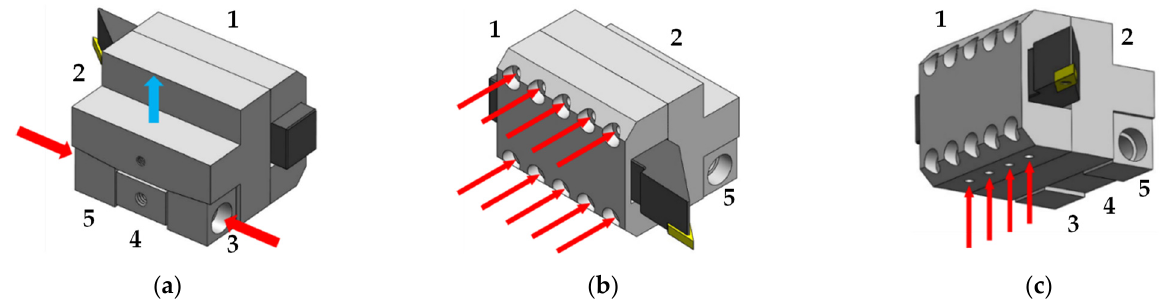
Figure 3. The structure of the smart tool holder consists of: ( a ) the five parts of the smart tool holder, including the front cover (part 1), the rear cover (part 2), and the wedge, composed of parts 3 to 5; ( b ) parts 1 and 2, which are assembled by ten M6 hexagon socket screws; and ( c ) the clamping tightness of the turning tool, which is adjusted by four M6 set screws.